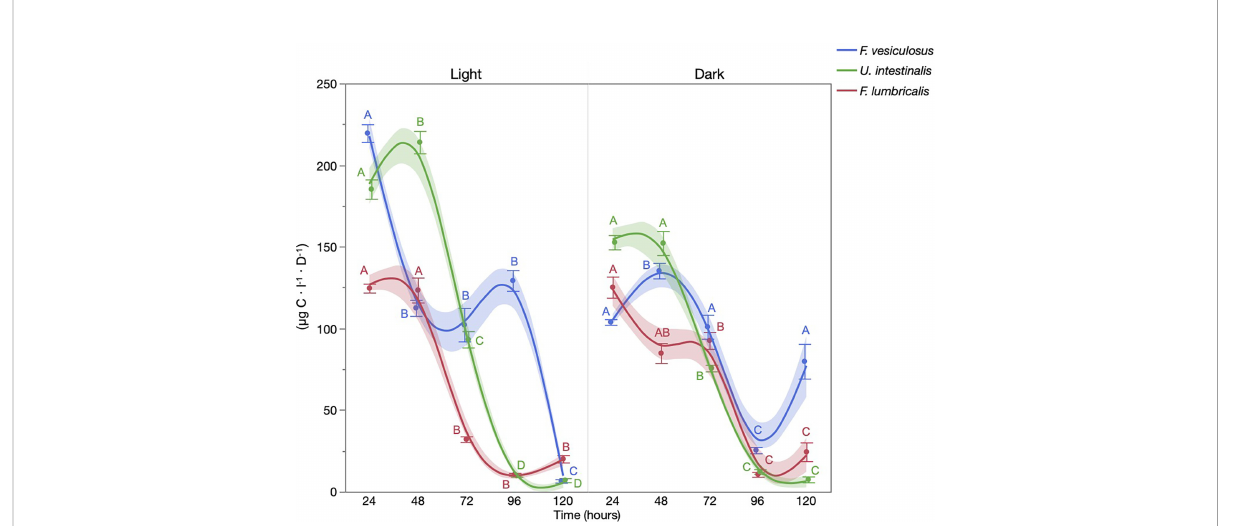
FIGURE 4 Heterotrophic bacterial biomass production (BBP) or carbon fl ux estimated (µg C·L − 1 ·D − 1 ) based on tritiated leucine incorporation rates for macroalgae DOC released under light and dark treatments. Different letters indicate signi fi cant difference within light and dark treatments (mean ± 1 SE, n = 5) (Tukey ’ s HSD, a = 0.05) (Smooth line = cubic spline with a lambda of